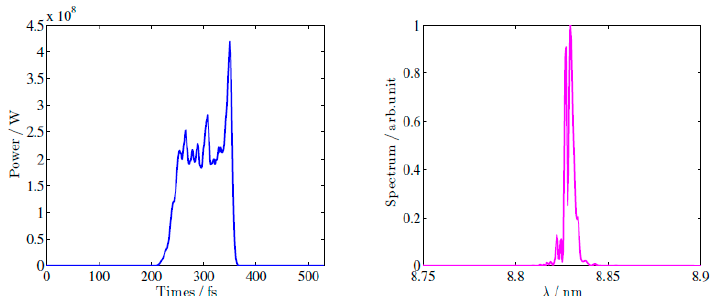
Figure 7. Simulated FEL performances of the cascaded echo-enabled harmonic generation (EEHG)-HGHG scheme at the SXFEL-TF: final output pulse at 8.8 nm in time ( left ) and spectral ( right ) domain.